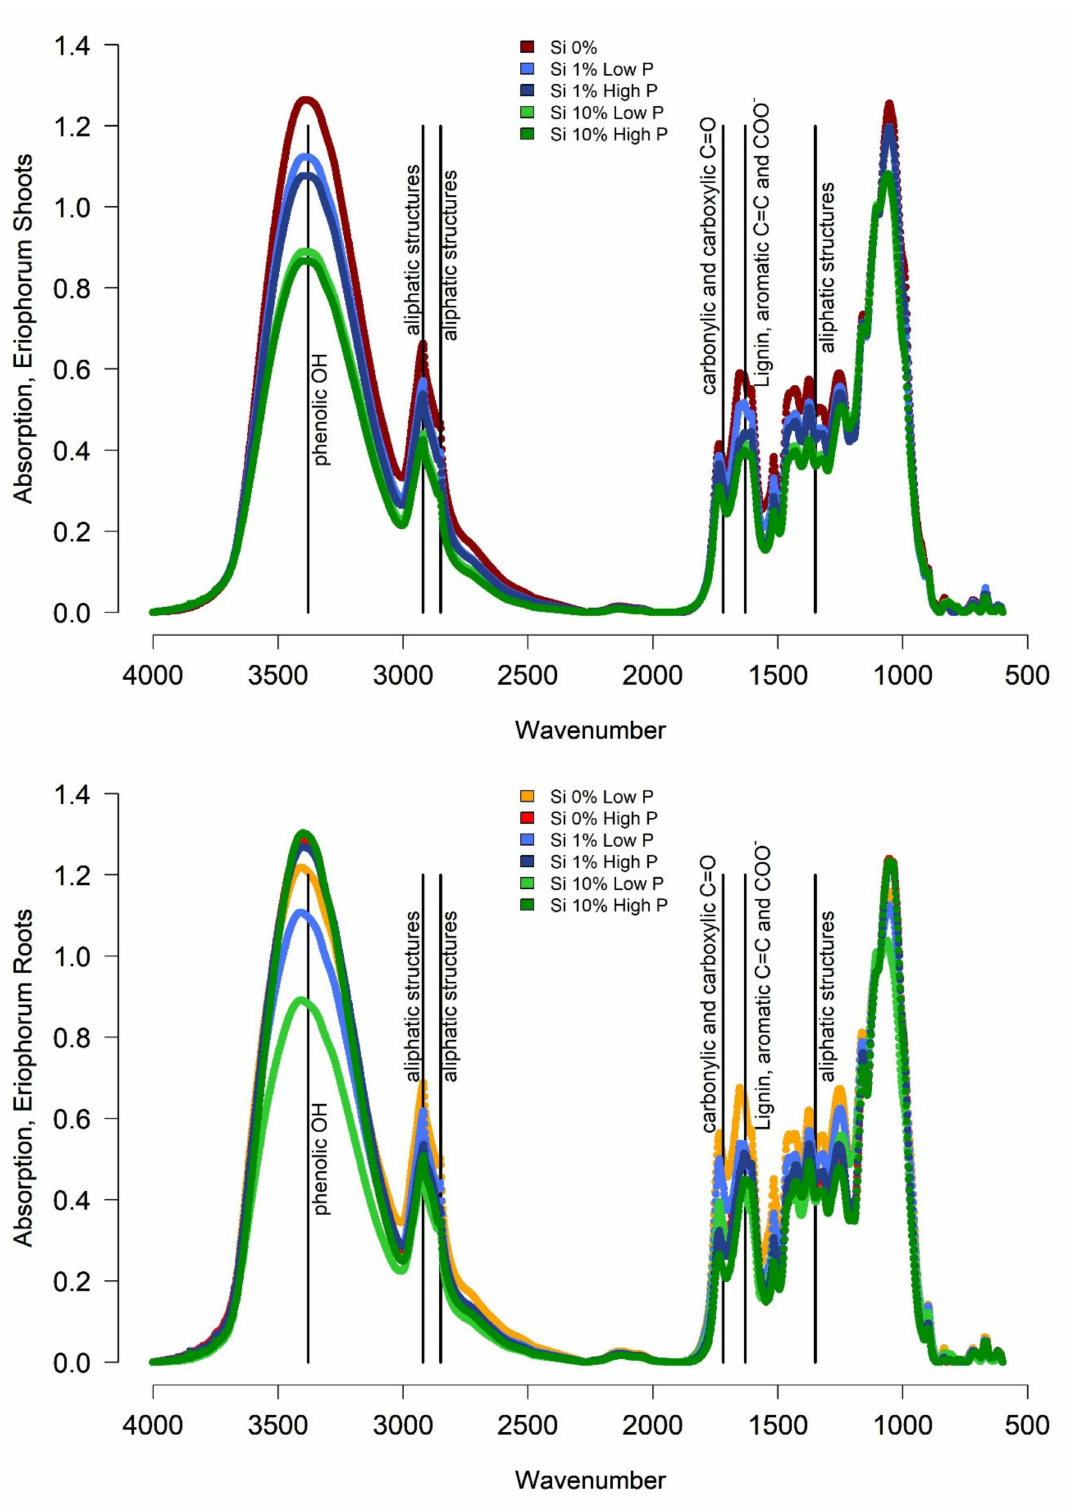
Figure 2. FTIR Spectra of Eriophorum shoots and roots before the incubation. For Eriophorum shoots only a mixed sample of the Si 0% low and Si 0% high P treatment is available (divergent color code: Si 0%: dark